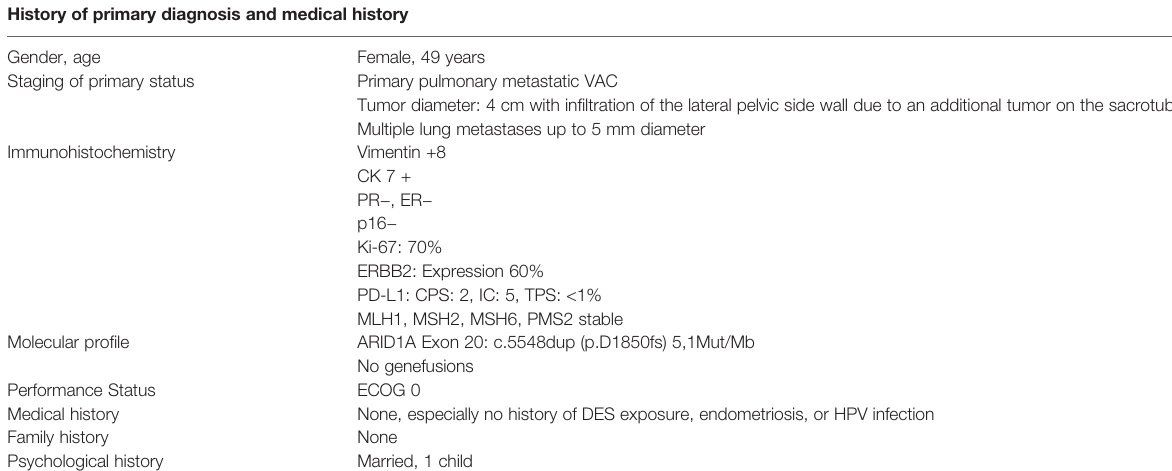
TABLE 1 | Medical history and clinical, histological, and molecular characteristics of the patient. History of primary diagnosis and medical